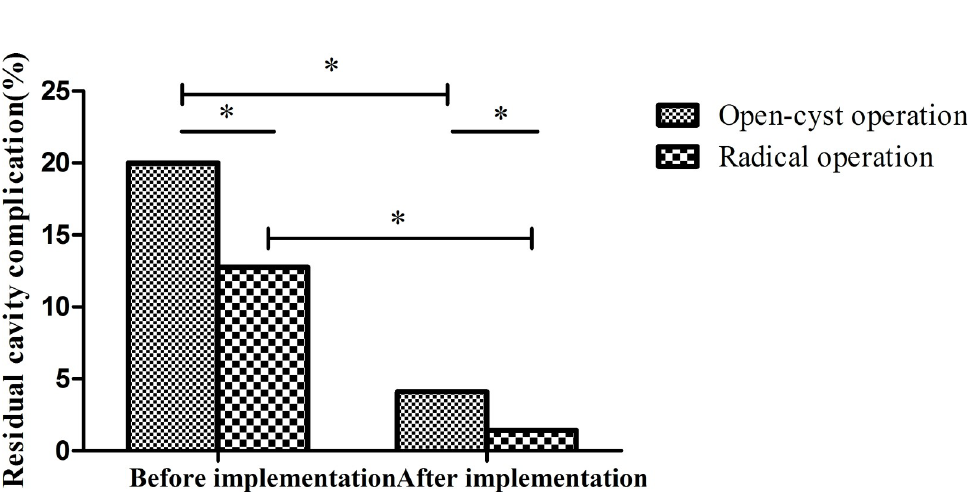
Fig 9. Complication rates following open-cyst versus radical operations. After program implementation, the residual cavity complications of the open- and closed-cyst operation decreased compared with that before the implementation, and the differences were statistically significant. ( � p < 0.001 by the chi-square